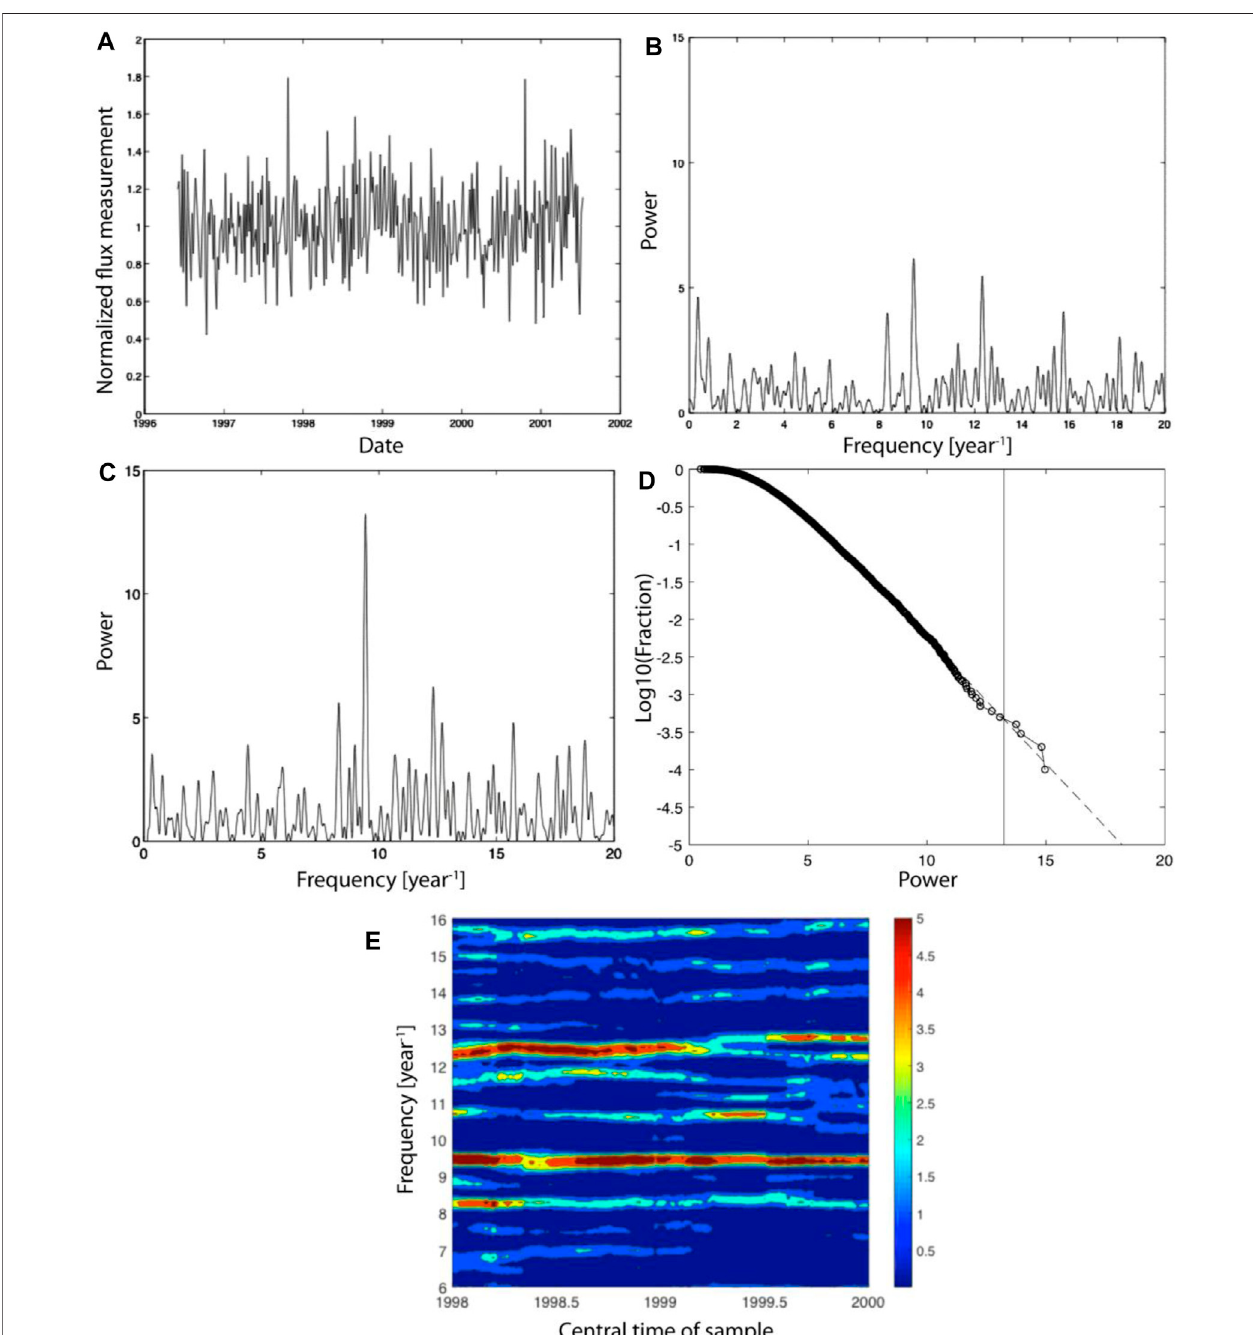
FIGURE 1 | (A) Plot of the normalized Super-Kamiokande fl ux measurements. (The mean fl ux measurement is 2 . 33 × 10 5 cm − 2 s − 1 ). (B) The Lomb-Scargle power spectrum formed from Super-Kamiokande data, as computed by Yoo et al. (2005), assigning fl ux measurements to the mean live time of each 5-days bin. (C) Power spectrum formed from Super-Kamiokande data, taking accountof start time, end time, fl ux estimate, lower error estimate and upper error estimate. The strongest peak is at 9.43 year − 1 , with power 13.24. (D) Shuf fl e test of the power spectrum formed from Super-Kamiokande data over a unit frequency band (6 – 7 year − 1 chosen, but the choice is unimportant). We fi nd that the probability of fi nding an oscillation of power 13.24 or more in a band of width 1 year − 1 is 4.5 × 10 – 4 . (E) Spectrogram formed fromSuper-Kamiokandedata,usinga “ slidingwindow ” ofwidth2.9 year.Theprincipalfeaturesareat9.4 year − 1 and12.5 year − 1 ,butthereisalsoaninteresting feature close to 8.4 year − 1